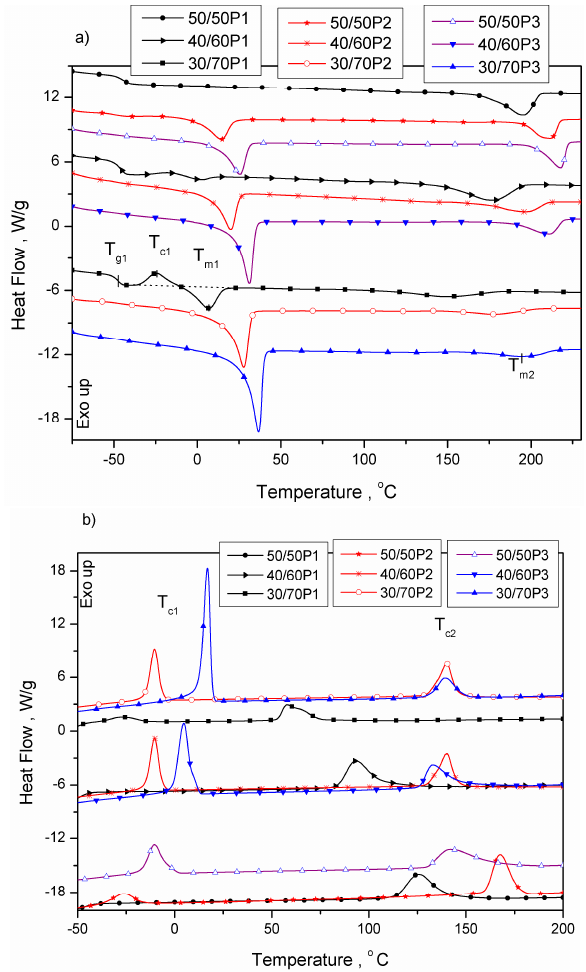
Figure 2. DSC thermograms obtained during 2nd heating ( a ) and cooling ( b ) for PTT- b -PEOT copolymers. Table 2. Thermal properties of PTT- block -PEOT copolymers .